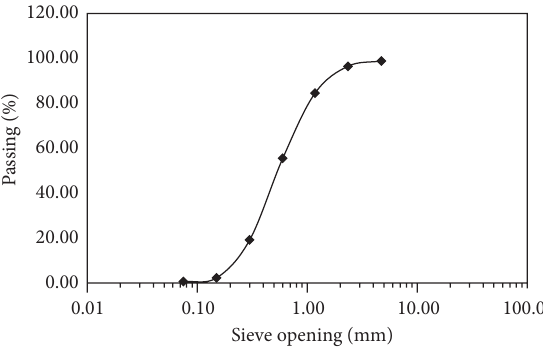
Figure 2: Gradation curve of fine aggregate (sand).